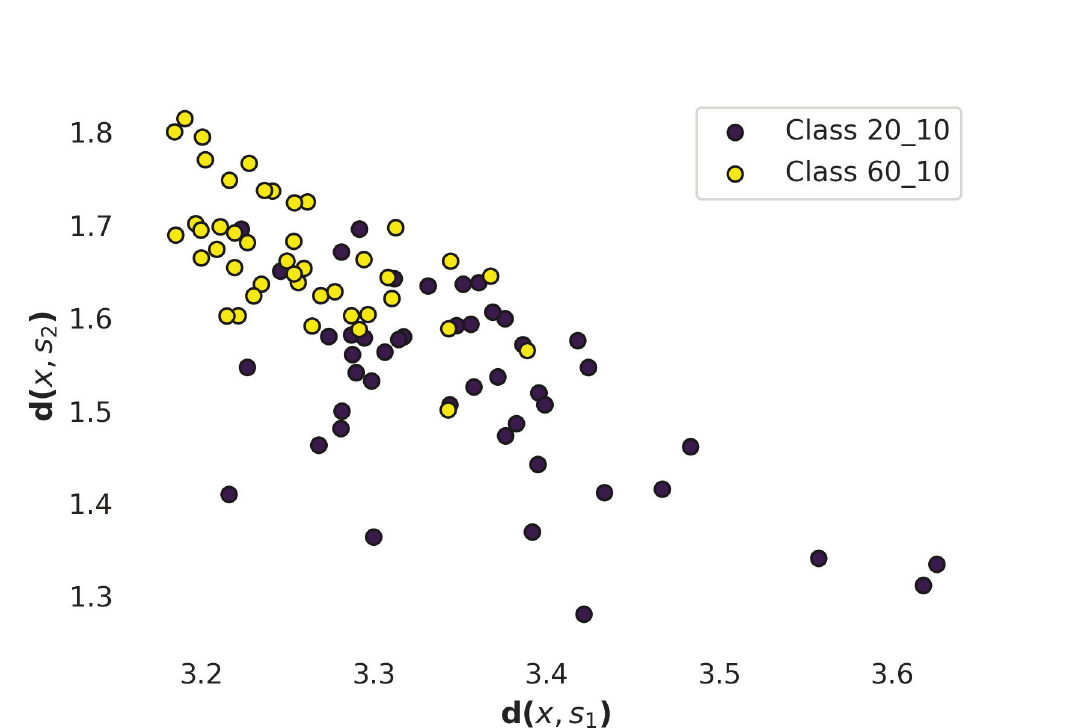
Fig 6. The shapelet–transform representation of the input data describing mitoBK activity obtained at membrane voltages U m = 20 mV (purple dots) and U m = 60 mV (yellow dots). Graph represents the distances d ( x , s 1 ) and d ( x , s 2 ) of all dwell time samples included in the dataset to two representative shapelets presented in Fig 4 calculated according to Eq 3.